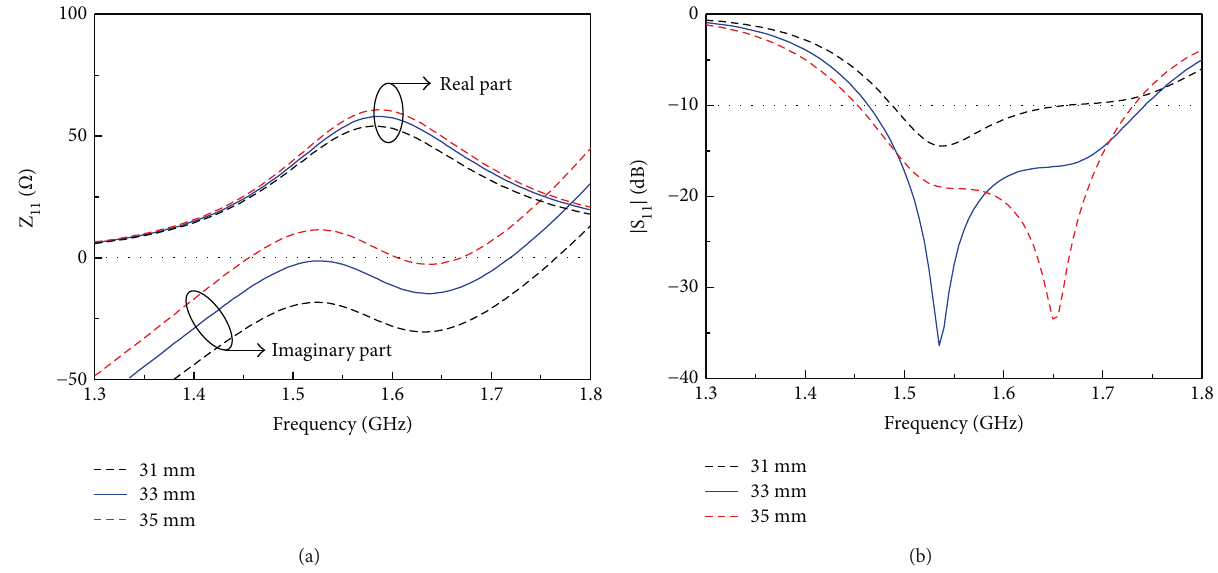
Figure 8: Simulated (a) input impedance and (b) |S lengths ( L d